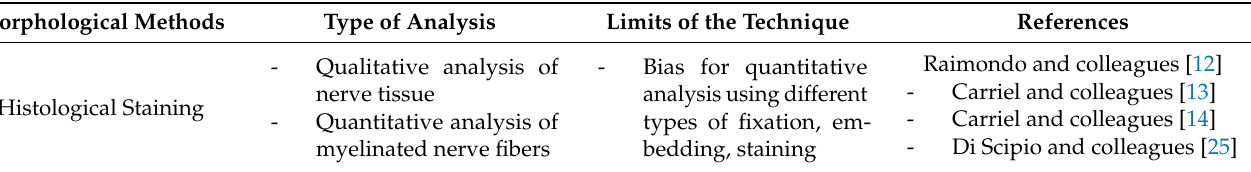
Table 4. Morphological methods for peripheral nerve regeneration